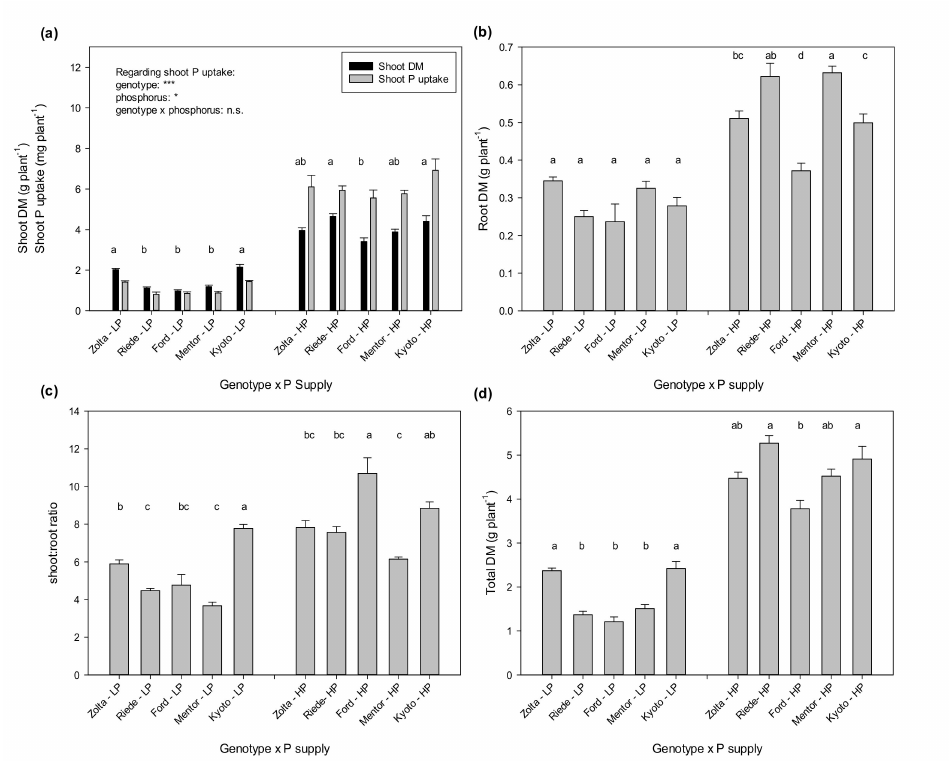
Figure 3. Experiment 2. Shoot dry matter (DM) and P uptake ( a ), root DM ( b ), shoot:root ratio ( c ), and total plant DM ( d ) of soybean genotypes at low P (LP) and high P (HP). * = p < 0.05, *** = p < 0.001, n.s. = not significant. The letters on top of each column represent Tukey’s HSD grouping. Error bars represent standard errors ( n = 6).